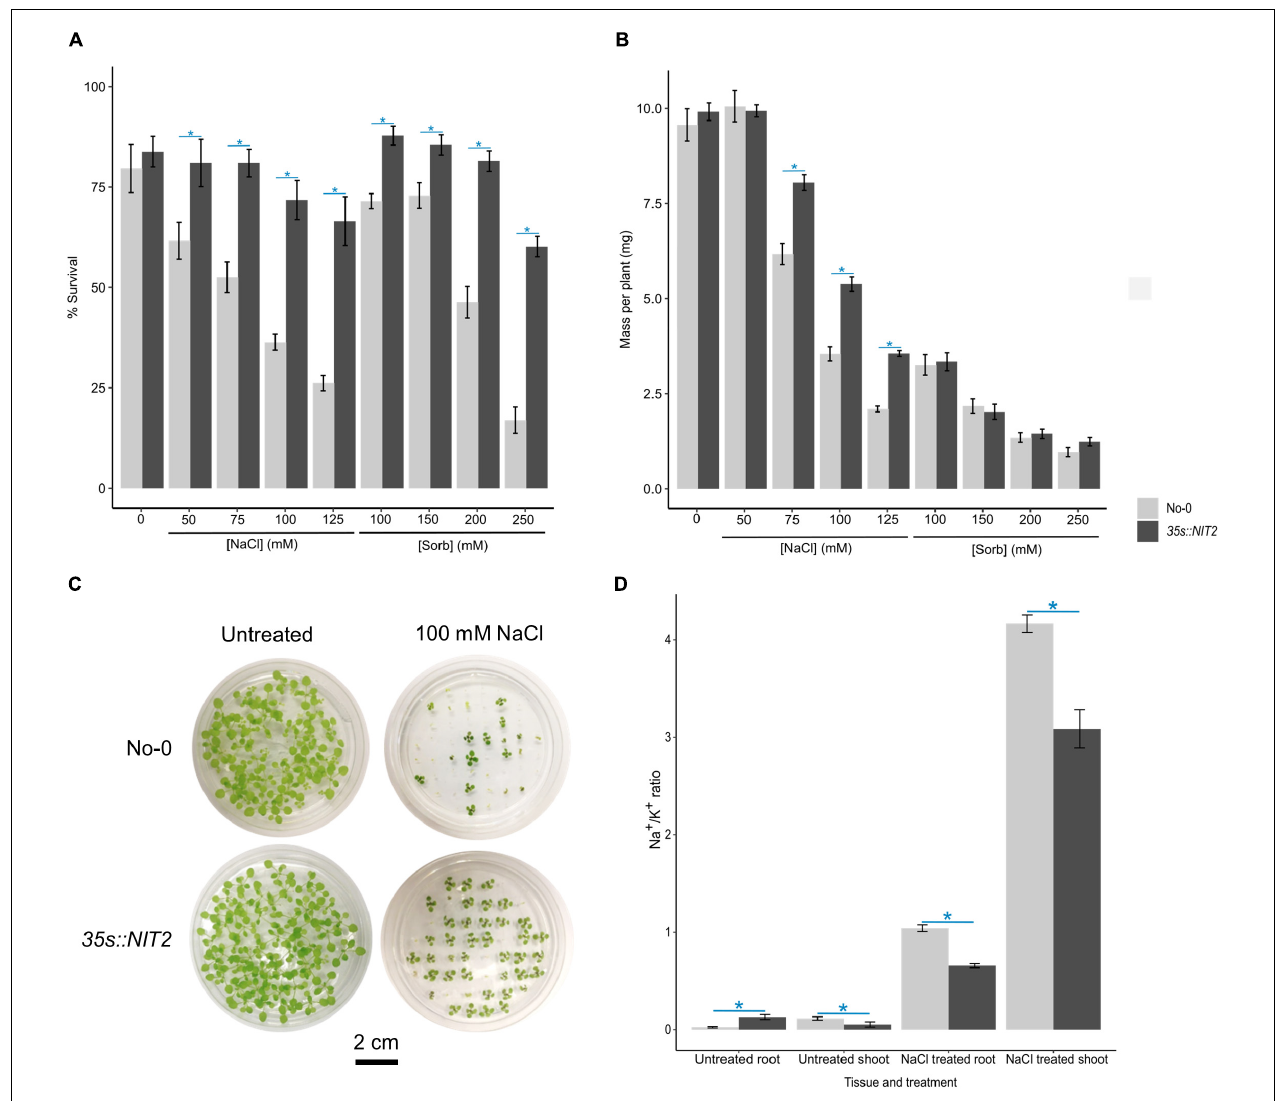
FIGURE 7 | Functional characterization of the Arabidopsis NIT2 overexpression line grown on NaCl and sorbitol. For (A - C), No-0 (wildtype) and 35s:NIT2 were germinated and grown for two weeks in petri dishes containing ATS media (0 mM, untreated control) and ATS supplemented with the indicated concentrations of NaCl and sorbitol (Sorb) and survival and plant growth (mass per plant) determined. The results are an average of three independent experiments. (A): The average% survival of No-0 and 35s:NIT2 in untreated, NaCl treated or sorbitol treated conditions. (B): The average mass per plant of No-0 and 35s:NIT2 in untreated, NaCl treated or sorbitol treated conditions. (C): A photograph of No-0 and 35s:NIT2 after two weeks growth on petri dishes containing ATS media and ATS supplemented with 100 mM NaCl. For (D), No-0 and 35s: NIT2 were grown hydroponically for three weeks on 1/4 strength ATS media then transferred onto 1/4 strength ATS media supplemented with 0 mM or 75 mM NaCl and grown for one additional week. The Na + and K + content in untreated and NaCl treated shoot and root tissue was determined via ICP-OES analysis and the Na + /K + ratio calculated. The results are the mean of six biological repeats. For all figures, the light gray bars represent No-0 and dark gray bars represent 35s:NIT2 . Error bars represent standard error. A star indicates a statistically significant difference in mean between No-0 and 35s: NIT2 in that treatment/tissue. Significance was determined by independent t-tests with a corrected p -value ≤ 0.05 considered significant. The Bonferroni method was used to correct p -values for multiple